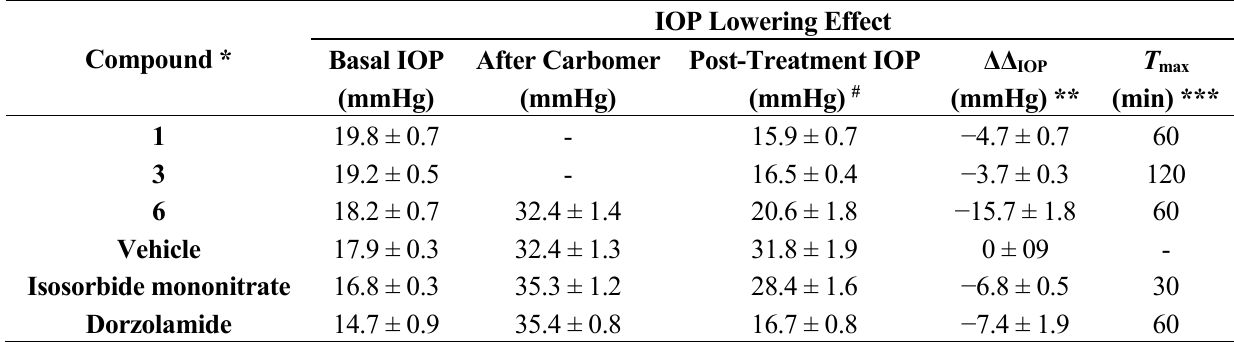
Table 3. Intraocular pressure (IOP) lowering effects of dorzolamide, isosorbide mononitrate and selected compounds ( 1 , 3 and 6 ) in normotensive New Zealand white